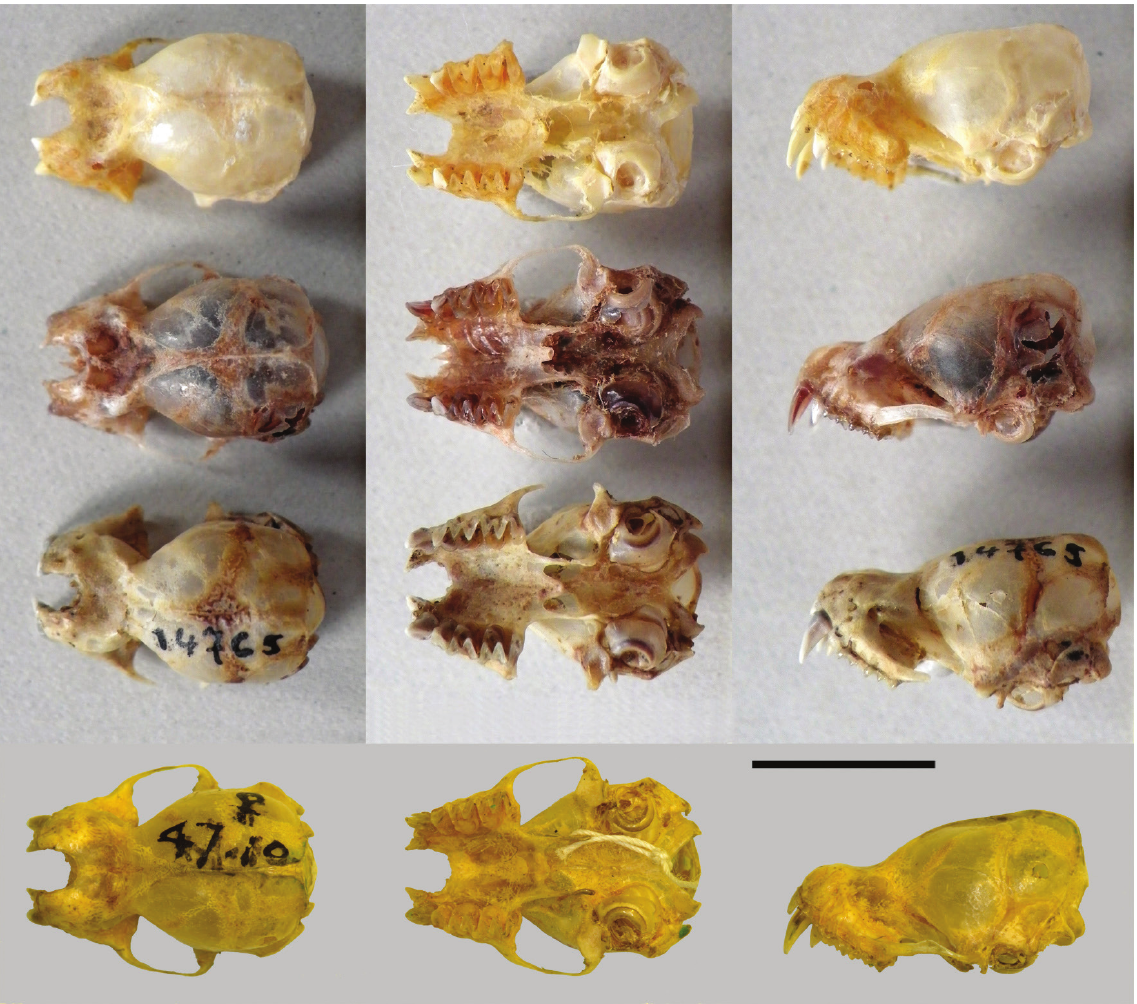
Fig. 5. Crania of the four known specimens of Glauconycteris superba Hayman, 1939 (left row: dorsal, middle row: ventral; right row: lateral). From top to bottom: specimen from Matonguiné (RMCA 97.077- M-7719, ♂), Mbiye Island (RMCA a1.097-M-3153, ♂), holotype of G. superba (RMCA 14765, ?), and holotype of G. s. sheila Hayman, 1947 (BMNH 47.10, ♀). Scale bar = 1